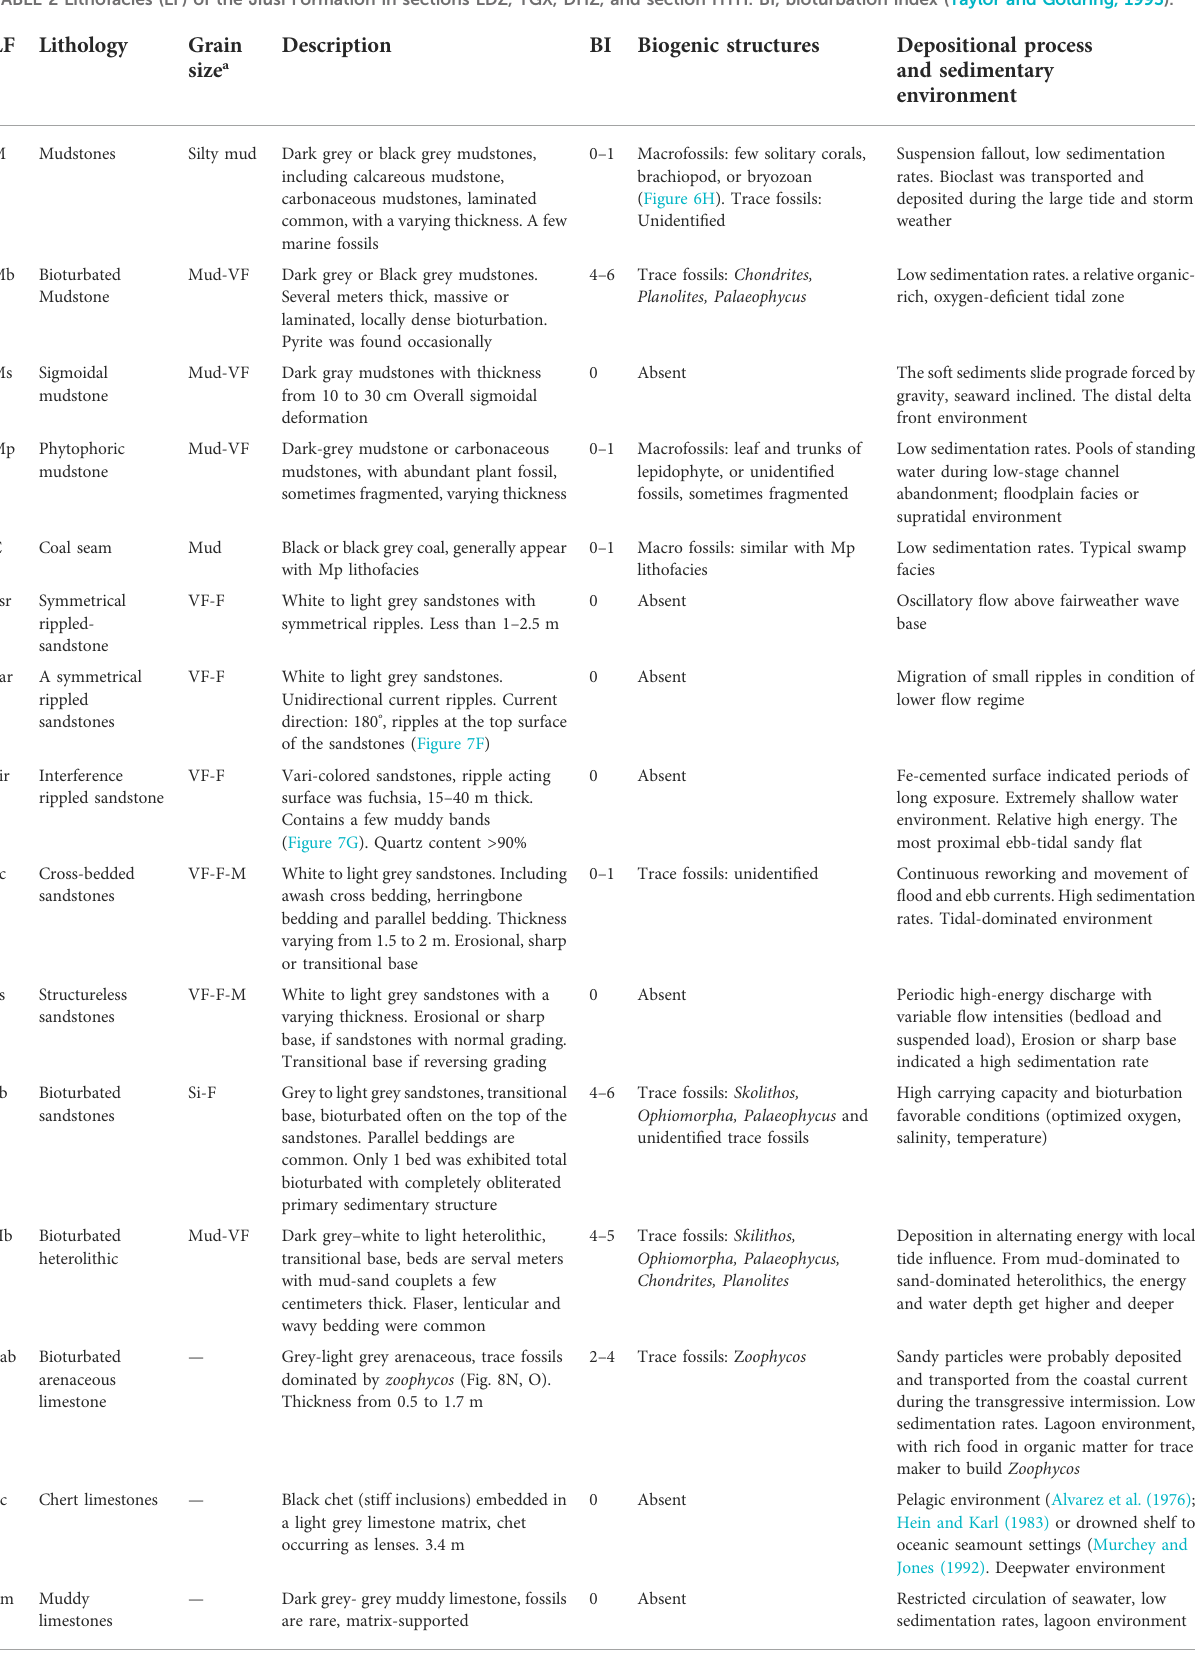
TABLE 2 Lithofacies (LF) of the Jiusi Formation in sections LDZ, YGX, DHZ, and section HTH. BI, bioturbation index (Taylor and Goldring, 1993). LF Lithology